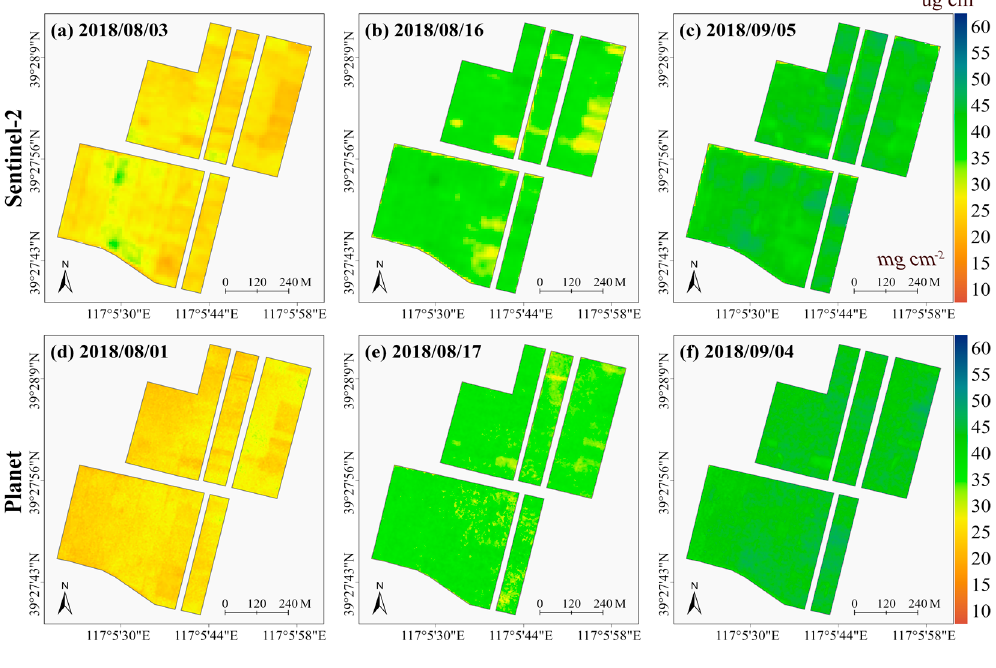
Figure 5. Multi-period maize LCC maps of Dajianchang Town obtained from ( a – c ) Sentinel-2 and ( d – f ) Planet imagery using the hybrid model.